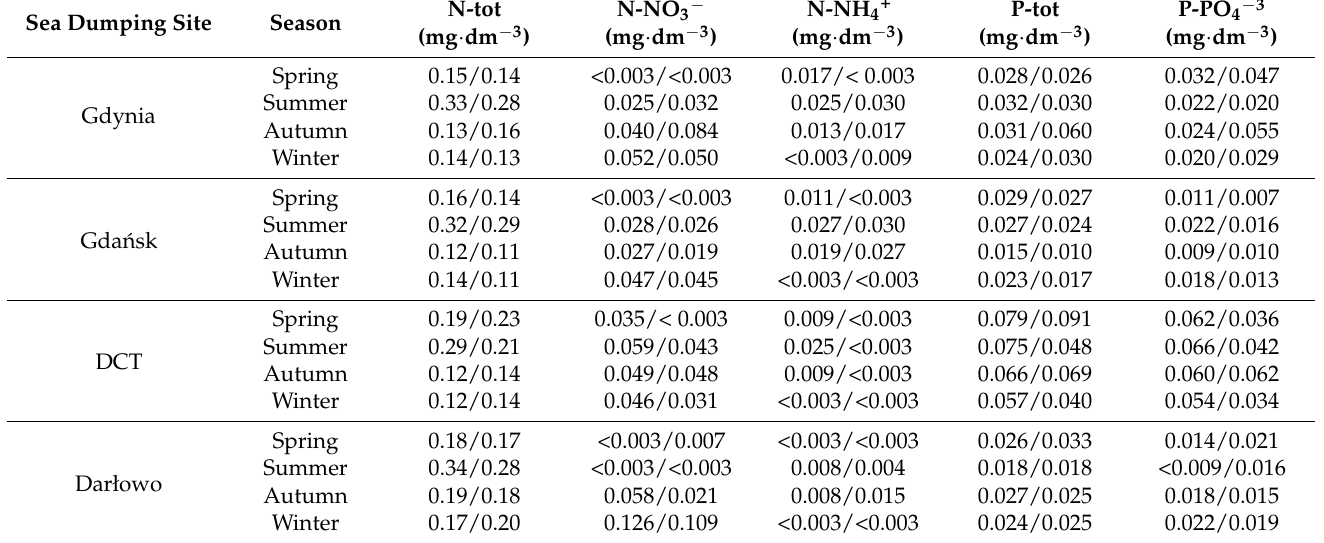
Table 2. Concentration of nutrients for the near-seabed layer averaged for all of the sampling sites of the given dumpsites (before the slash) versus data coming from the reference points (after the slash); “<” if a result is below the lower limit of